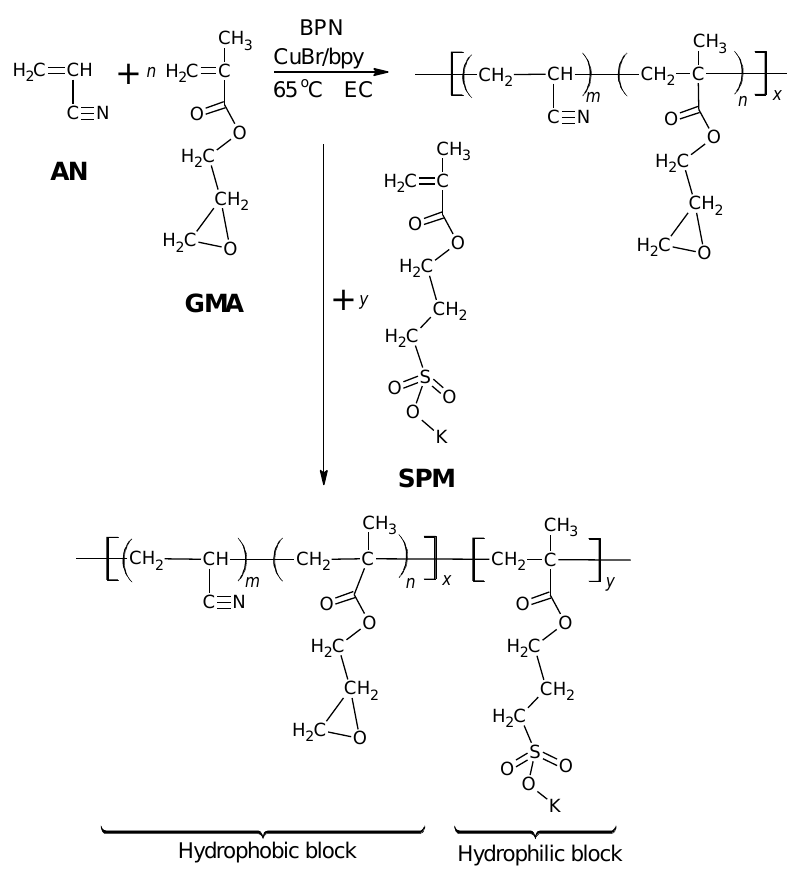
Figure 2. Synthesis of P[(AN- co -GMA)- b -SPM] diblock ionomer by the atom transfer radical polymerization (ATRP) technique.